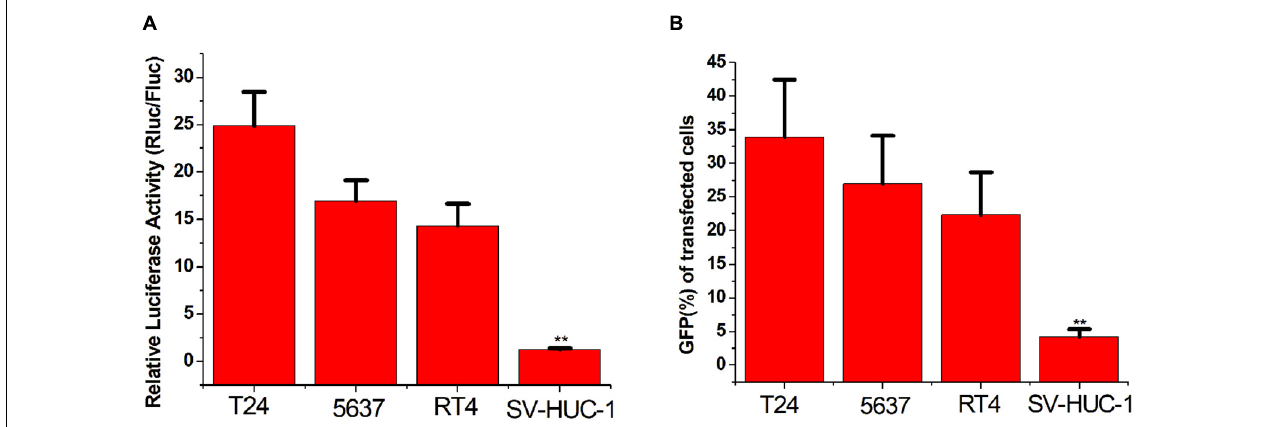
FIGURE 2 | Distinguishing between bladder cancer cells and normal cells. (A) Cell luciferase activity was determined using the dual luciferase reporting assay (** p < 0.01). Data were expressed as mean ± SD. (B) Cell GFP expression was determined using the GFP reporter assay (** p < 0.01). Data were expressed as mean ±